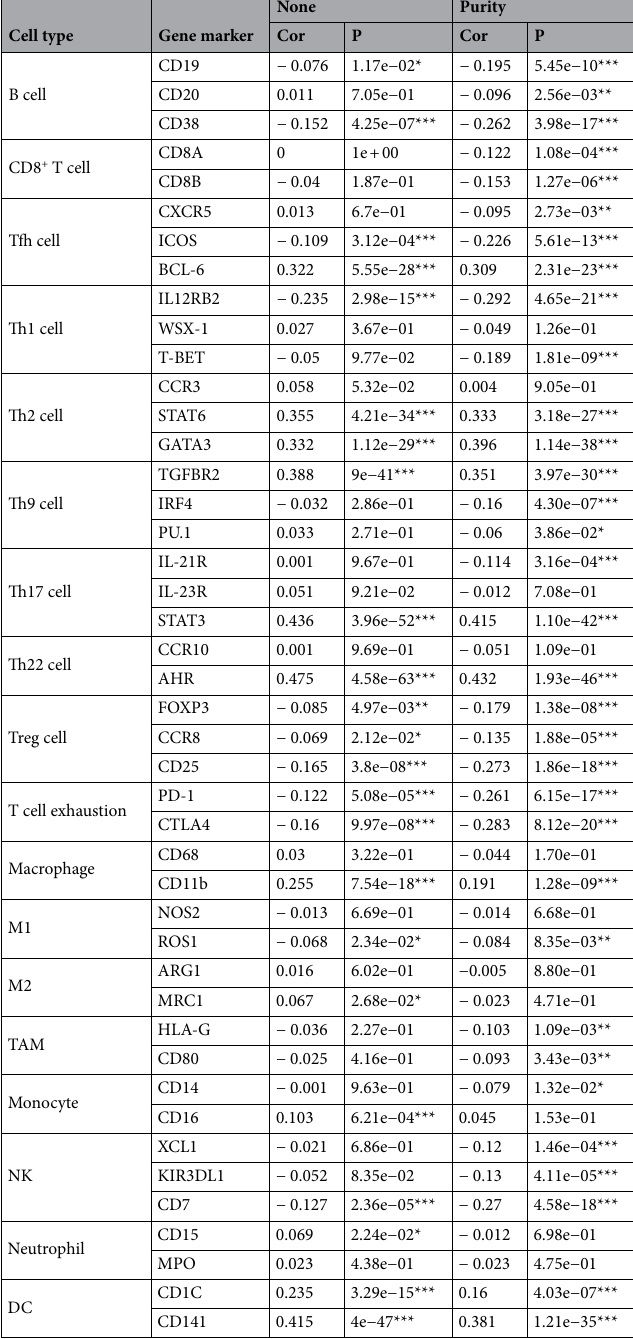
Table 3. Correlations between NTN4 and gene markers of immune